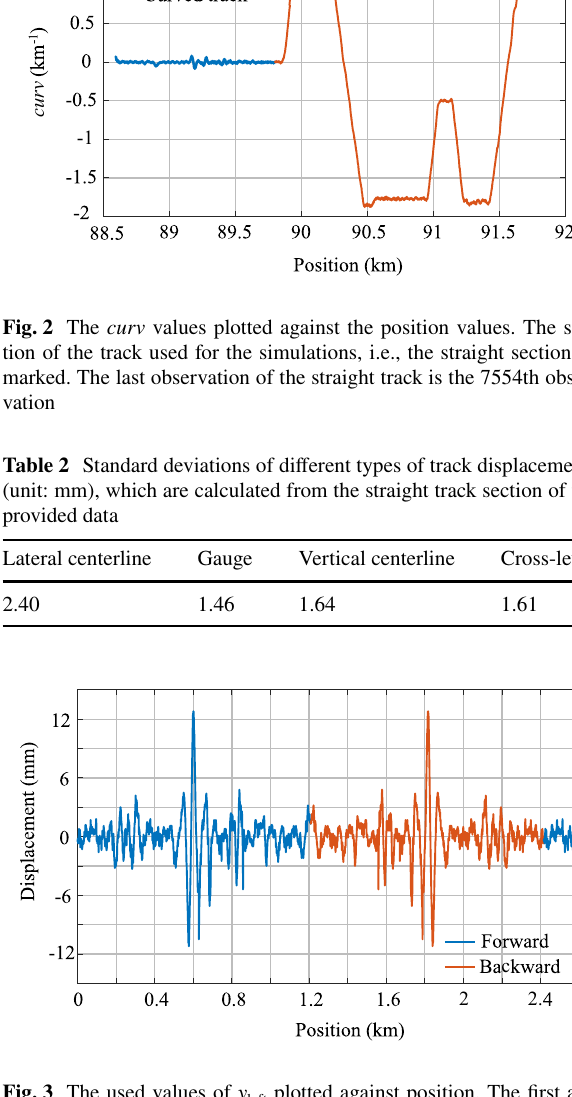
Fig. 3 The used values of y left plotted against position. The first and the 7554th observation are not replicated when the track is flipped